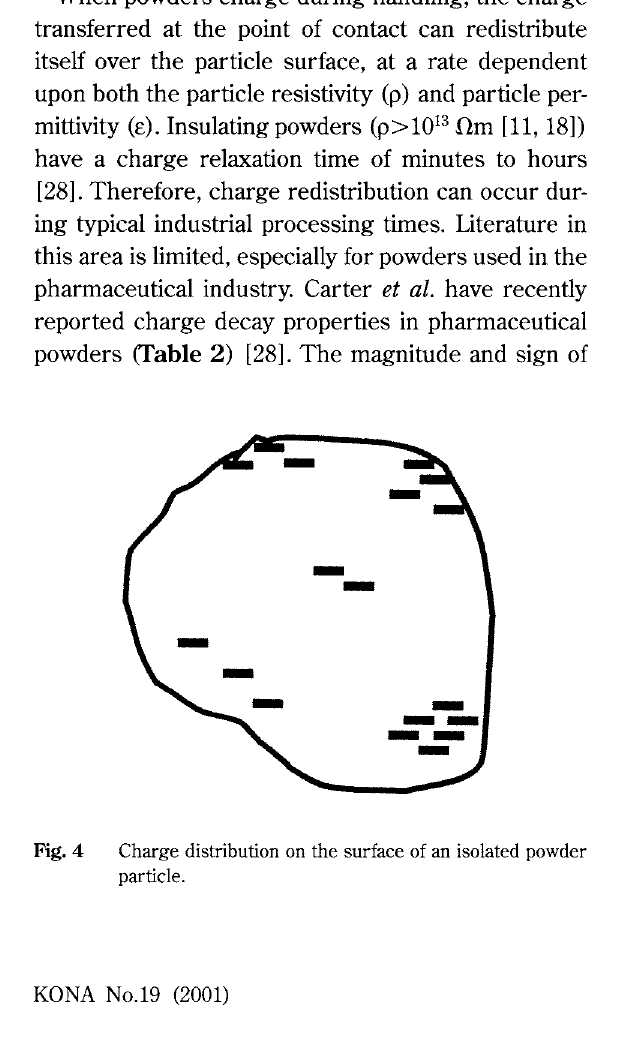
Charge distribution on the surface of an isolated powder particle.